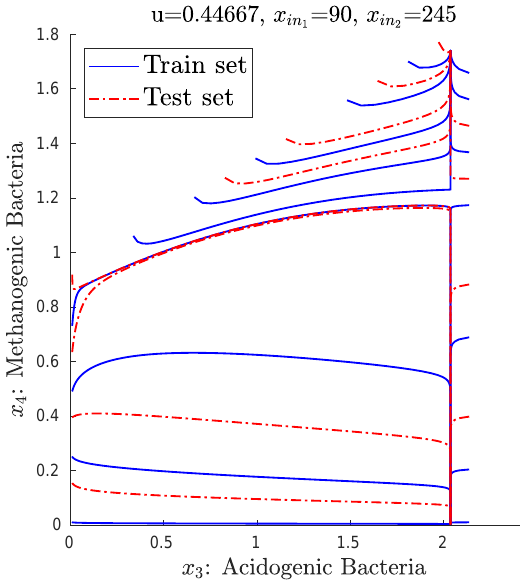
Figure 2: Training and testing sets of snapshots for the approxima- tion of the discrete-time Koopman operator. Initial conditions are uniformly distributed in the boundary of S x